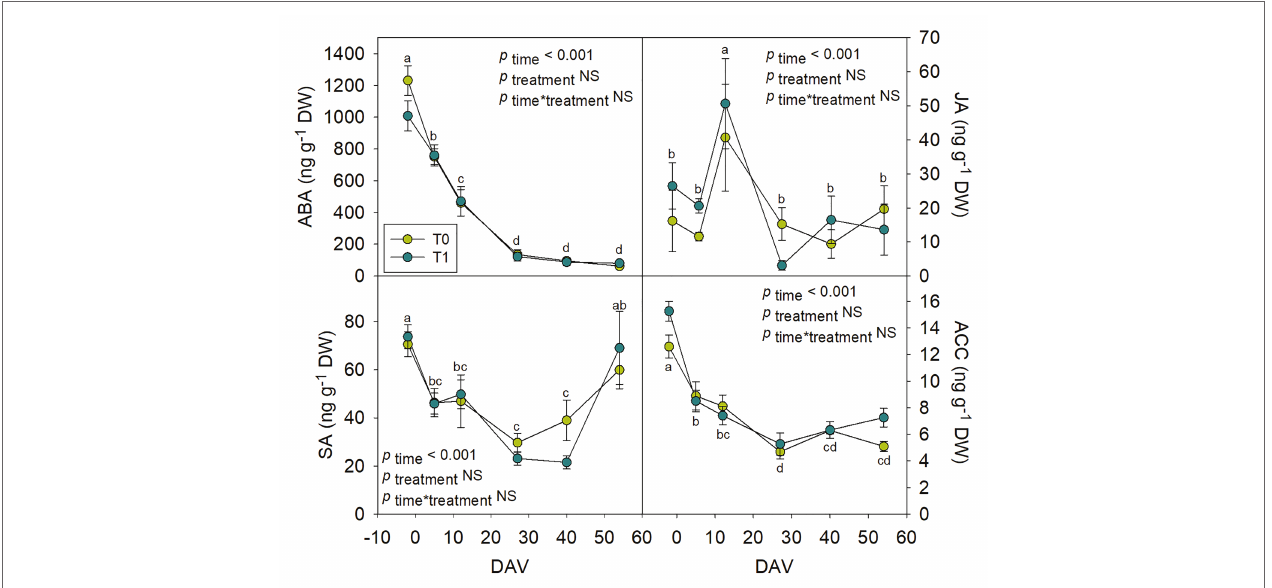
FIGURE 2 | Endogenous variations in abscisic acid (ABA), jasmonic acid (JA), salicylic acid (SA), and the ethylene precursor 1-aminocyclopropane-1-carboxylic acid (ACC) in whole berries of “Merlot” grapes during ripening in non-irrigated (T0) and irrigated (T1) vineyards. ABA, JA, SA, and ACC contents in grapes throughout ripening are shown. Vertical bars indicate SE of six replicates. Different letters denote significant differences among sampling dates (Tukey’s HSD post-hoc test p < 0.05). No significant differences between treatments were observed ( p >